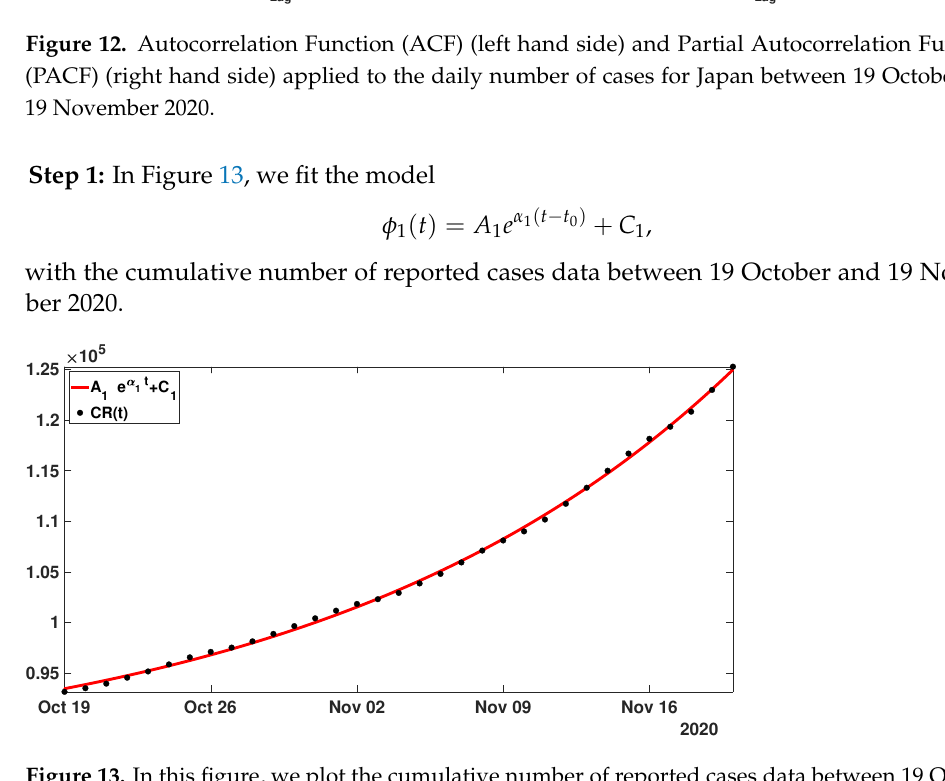
Figure 13. In this figure, we plot the cumulative number of reported cases data between 19 October and 19 November 2020 (black dots). we plot the best fit of the model (27) to the cumulative data (red